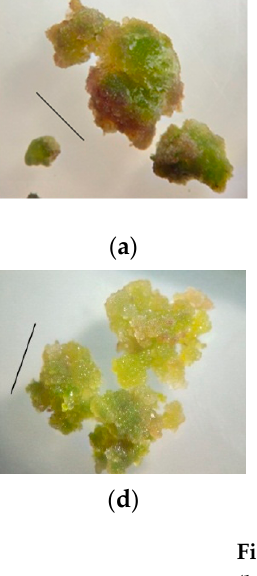
Figure 2. Appearance of the primary callus and regenerant plants of S. hortensis : ( a ) callus from cotyledon leaves, ( b ) callus from hypocotyls, and ( c ) regenerant plants. Bars—0.5 cm.